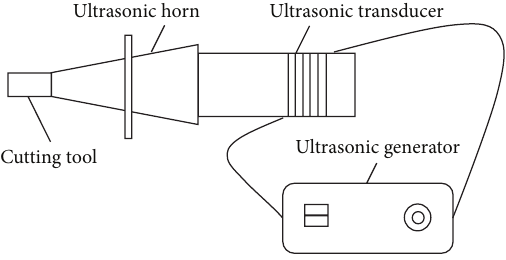
Figure 3: Structure sketch of ultrasonic vibration